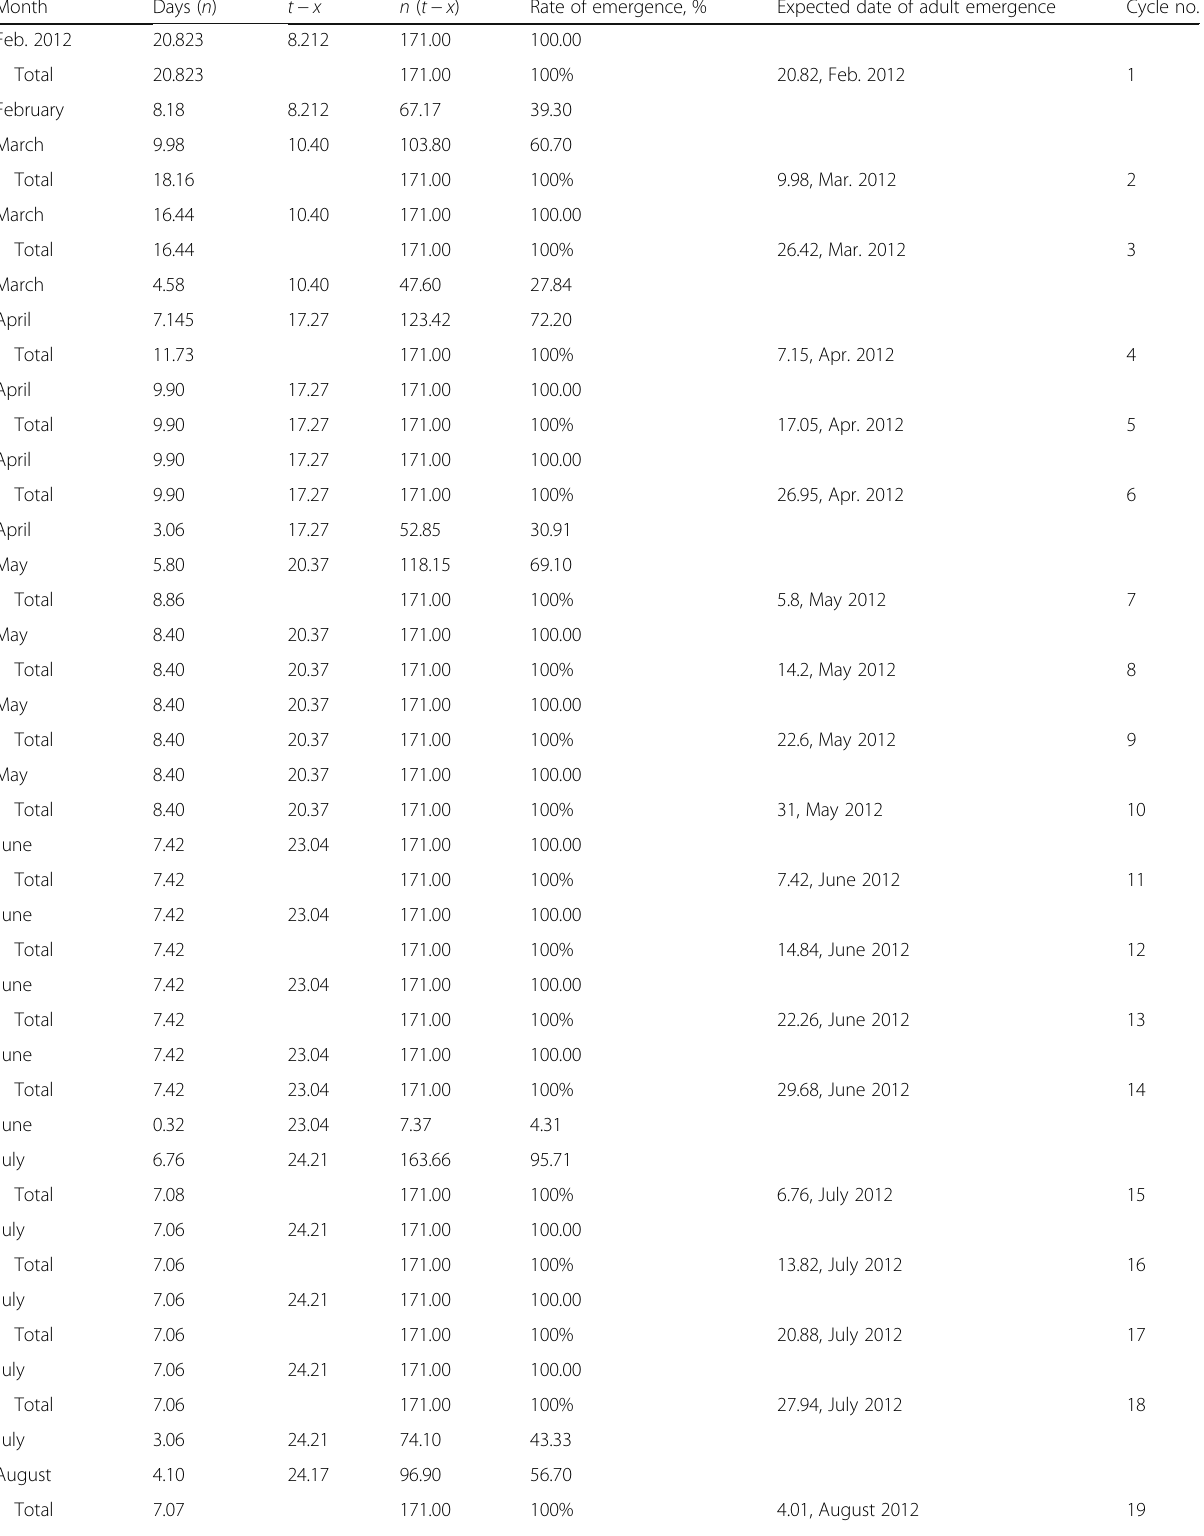
Table 1 Expected frequencies of emergence of Tuta absoluta moths in the Egyptian fields Month Days ( n ) t − x n ( t − x ) Rate of emergence, % Expected date of adult emergence Cycle